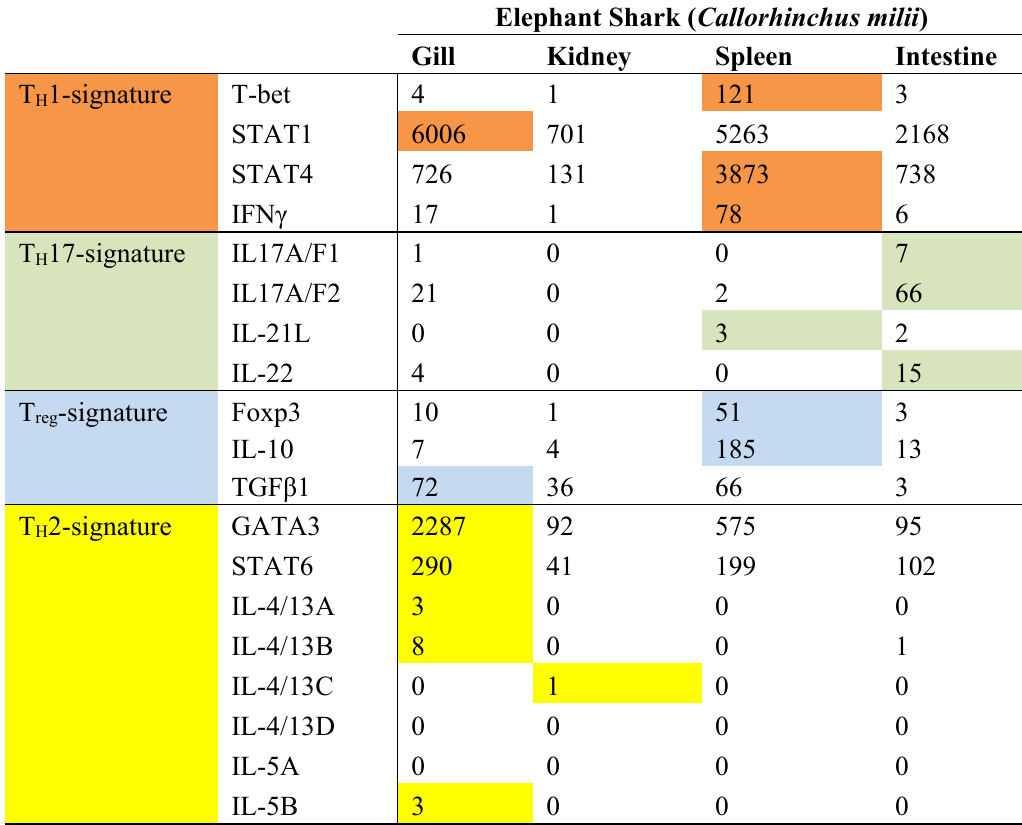
Table 1. Expression levels of immune signature genes in various tissues determined by BLAST analysis against cartilaginous and teleost fish sequence read archive (SRA) datasets. Read numbers per 5 × 10 7 reads of various immune signature genes of cartilaginous and teleost fish species were determined by similarity searches against tissue-specific SRA datasets (from http://www.ncbi.nlm.nih.gov/Traces/sra/ (data not shown); see Table 1C) using the BLAST search function at NCBI (http://blast.ncbi.nlm.nih.gov/Blast.cgi). ORF sequences (see supplementary file 2) were subjected to “Megablast” analysis (blastn) using default software settings except that the “max target sequences” number was changed to 20,000 and that the “word size” number was changed to 64. To ensure specificity of the Megablast analysis, only matches with “score” values ≥128 for elephant shark, ≥251 for golden mahseer, ≥168 for northern pike and Atlantic salmon, and ≥169 for rainbow trout, were counted. Colored backgrounds highlight the tissues with the highest relative expression of the respective gene, and the red frames highlight the consistent high expression of IL-4/13A and GATA-3 in teleost